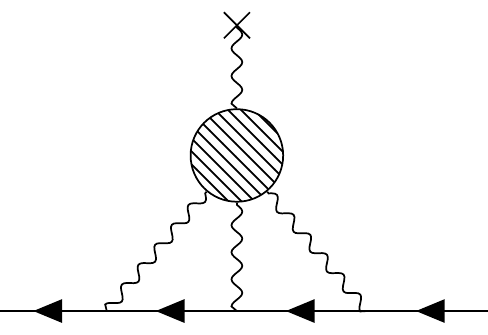
Figure 1 . Hadronic light-by-light scattering diagram in the muon ( g − 2)